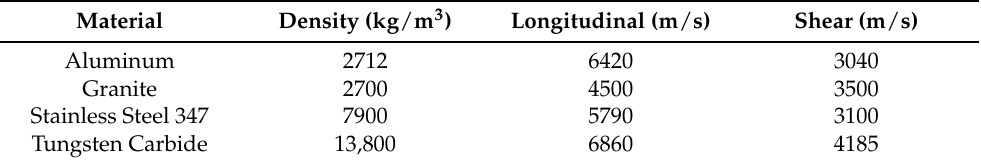
Table 1. Material properties used for simulating backscattered responses. Data from the Engineering Toolbox [35].